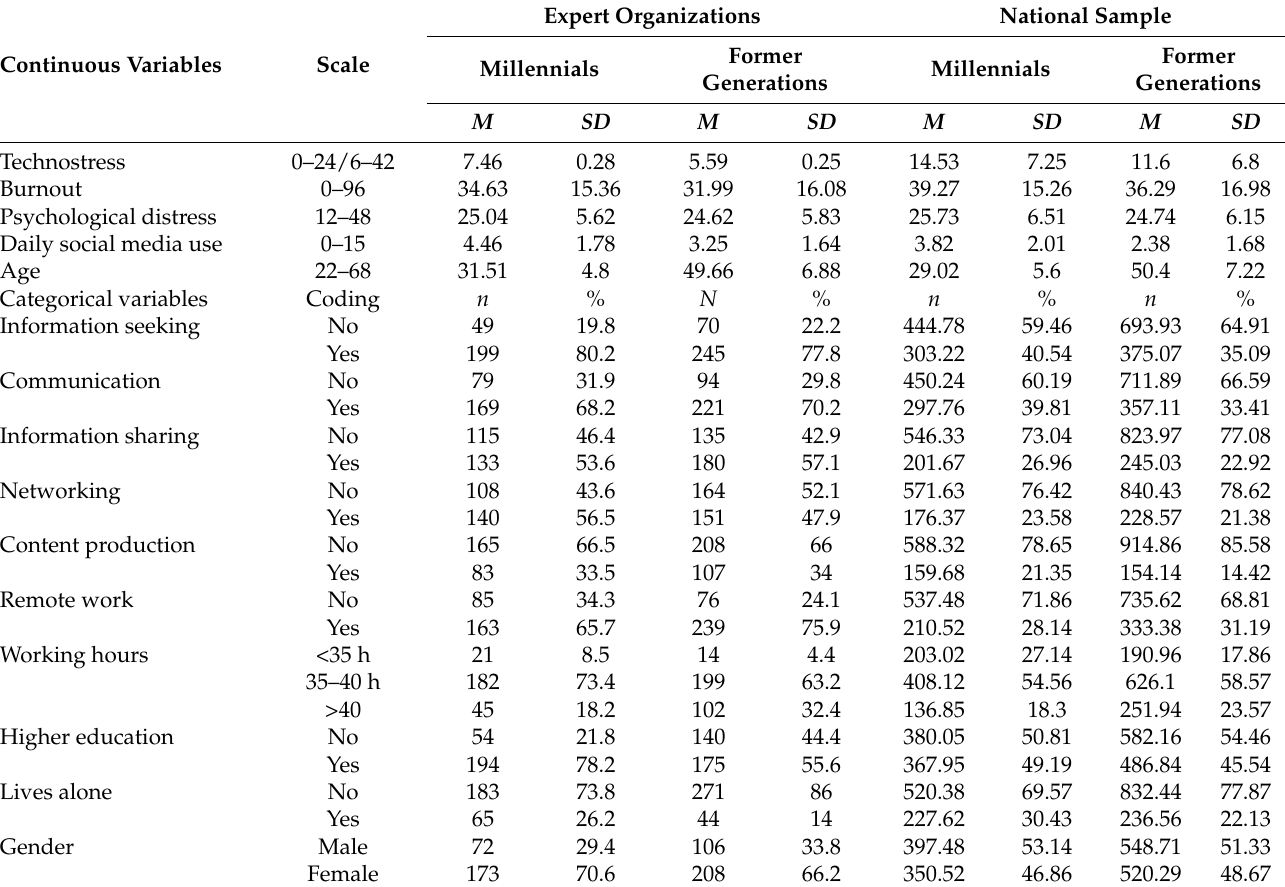
Table 2. Descriptive statistics on expert organization sample ( N = 563) and national sample (T1, N =